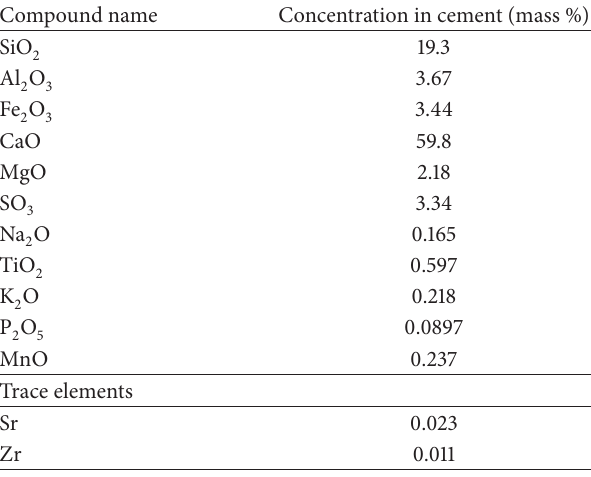
Table 3: Chemical composition of ordinary portland cement as determined by XRF.